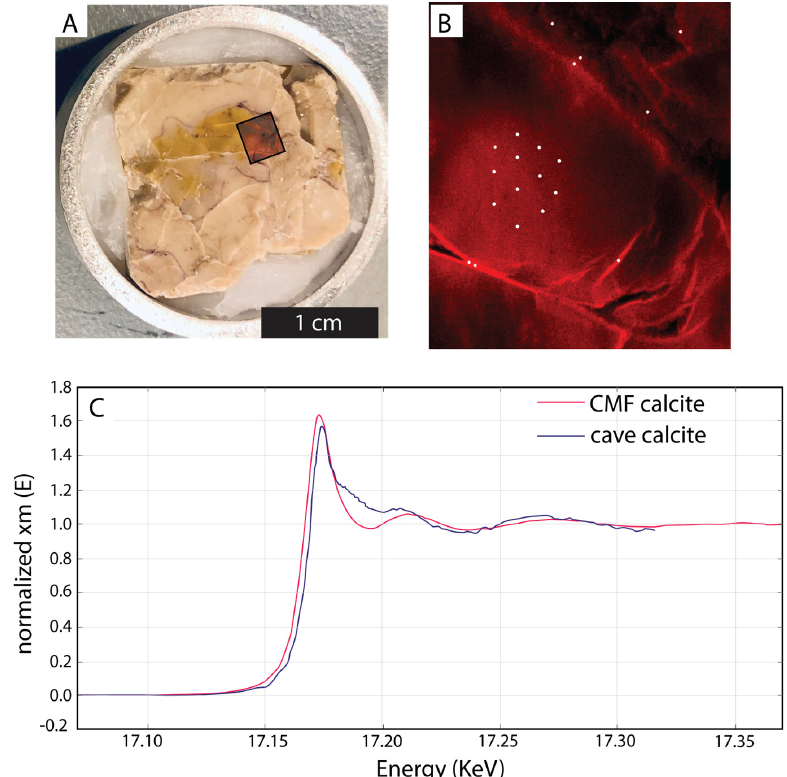
Figure 6. XANES and XRF results of the U-enriched portion of stratum 2. ( A ) Slab of the studied carbonate sample of the Cedar Mountain Formation. The boxed area with the red image is the location of the uranium map in ( B ). ( B ) XRF map of U. The brighter red corresponds to higher U concentrations. Dark areas have lower U concentrations. The white spots are the locations of U-XANES scans. ( C ) Merged U-XANES from the Cedar Mountain Formation carbonate, as well as a cave carbonate with published EXAFS, indicating aligned peaks around 17,153 eV consistent with UO 2 .